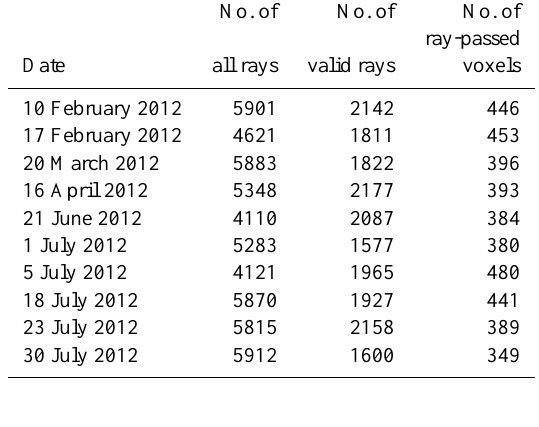
Table 3. RMS of differences between PPP-derived and tomography-derived SWV based on the a priori information of water vapour density acquired from COSMIC RO data (mm).